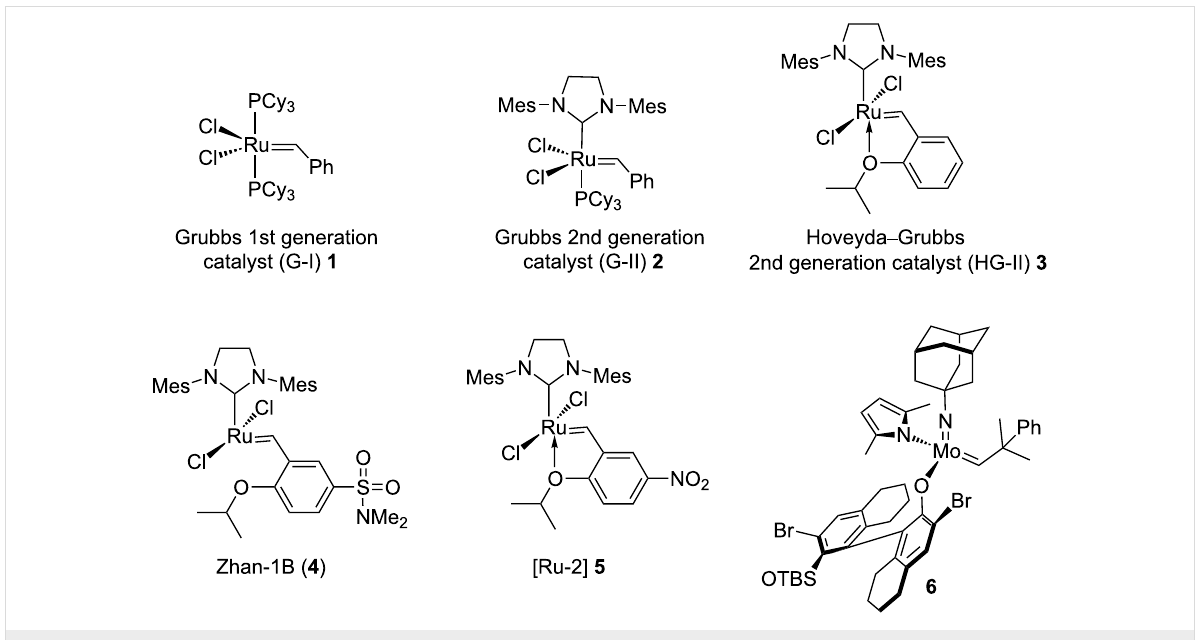
Figure 1: Various catalysts used for metathesis reactions.